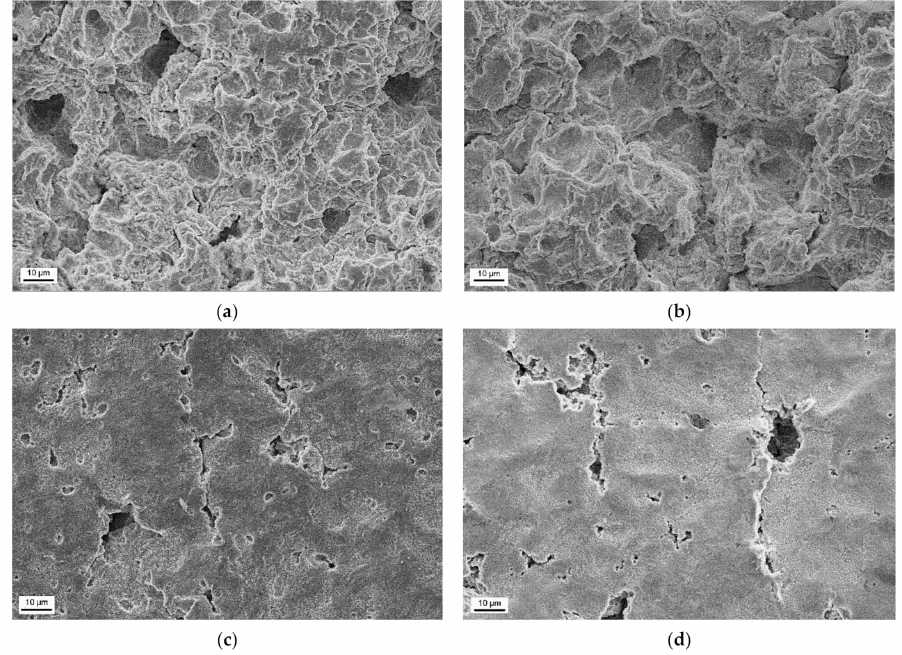
Figure 17. Surface damages developed during cavitation erosion tests carried out at a flow velocity of 43 m/s in the high erosion zone of ( a ) S235JR-AR steel and ( b ) S235JR-TT steel, and in the low erosion zone of ( c ) S235JR-AR steel and ( d ) S235JR-TT steel. Damages to the surface of hard S235JR-AR and soft S235JR-TT steels in the strongly eroded zone and tested at a flow velocity of 35 m/s have the form of pits or so-called cavitation tunnels, voids and cracks developing in a ductile mode (Figure 16a,b). Cracks are a bit wider for soft S235JR-TT steel, indicating the effect of the steel hardness.